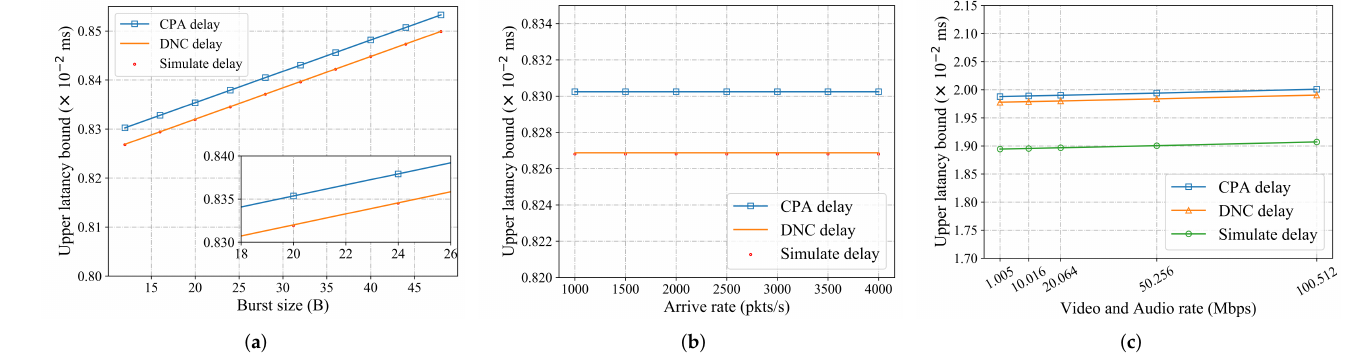
Figure 3. Single flow and multi-flow with single switch: ( a ) CPA delay, DNC delay and simulate delay versus burst size when the arrival rate is 1000 pkts/s, ( b ) CPA delay, DNC delay and simulate delay versus arrival rate when the burst size is 12 B, and ( c ) effect of interference flow rates on the end-to-end delay of the target